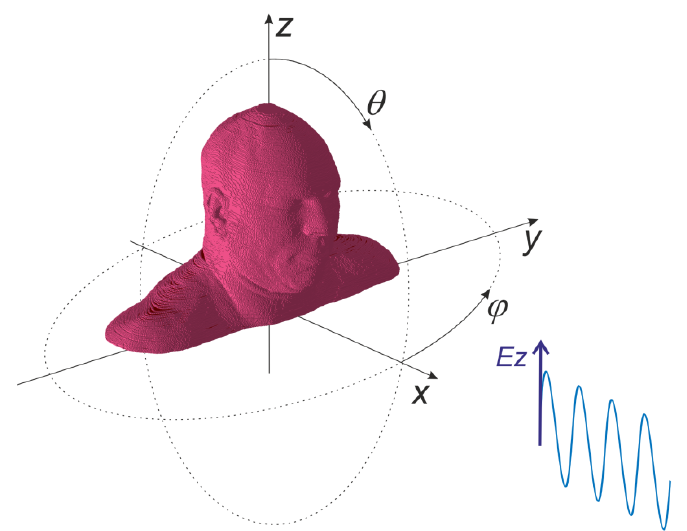
Figure 3. Geometry of the experiment with vertically polarized incident wave.